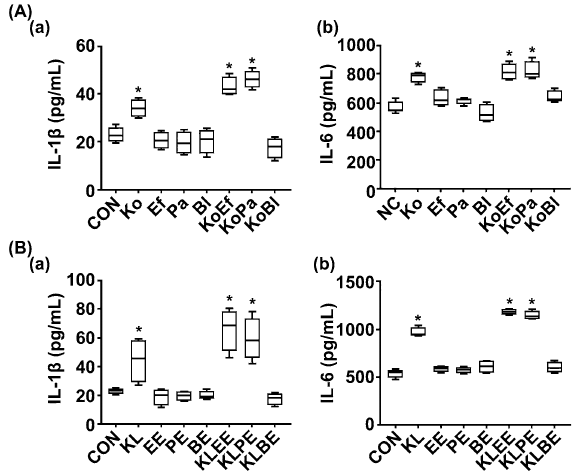
Figure 7. Effects of Enterococcus faecium, Pediococcus acidilactici , and their exopolysaccharides on Klebsiella oxytoca - or its lipopolysaccharide-induced IL-1β and IL-6 expression and NF-κB activation in macrophages. ( A ) Effects of gut bacteria on IL-1β (a) and IL-6 expression (b) in macrophages. ( B ) Effects of gut bacterial LPS and EPS on IL-1β (a) and IL-6 expression (b) in macrophages. Test agents (CON, vehicle [saline]; Ef, 1 × 10 5 CFU/mL of Enterococcus faecium (Ef); Pa, 1 × 10 5 CFU/mL of Pediococcus acidilactici ; Bl, 1 × 10 5 CFU/ mL of Bifidobacterium longum ; Ko, 1 × 10 5 CFU/mL of Klebsiella oxytoca; KoEf, 1 × 105 CFU/mL of Ko and Ef (1:1); KoPa, 1 × 10 5 CFU/mL of Ko and Pa (1:1); KoBl, 1 × 10 5 CFU/mL of Ko and Bl (1:1). KL, 100 ng/mL of Ko lipopolysaccharide (LPS); EE, 100 ng/mL of Ef expolysaccharide (EPS); PE, 100 ng/mL of Pa; BE, 100 ng/mL of Bl; KLEE, 100 ng/mL of Ef EPS with 100 ng/mL of Ko LPS; KLPE, 100 ng/mL of Pa EPS with 100 ng/mL of Ko LPS; KLBE, 100 ng/mL of Bl EPS with 100 ng/mL of Ko LPS) was treated in macrophages. The macrophages were treated with LPS (80 ng/mL) in the presence or absence of Ef, Pa, their EPSs, Ko, and/or its LPS for 20 h. Cytokine levels were assayed using ELISA kits. Data are shown as box plots (n = 6). *p < 0.05 vs Con. All were analyzed using unpaired t